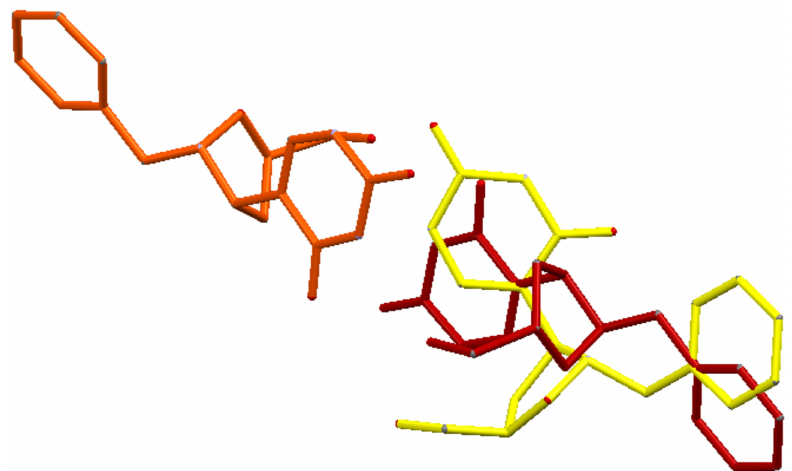
Figure 6. Structures overlay and comparison: X-ray inferred one (red and orange, Z’ = 2) and docked (yellow). (For interpretation of the references to color in this figure legend, the reader is referred to the web version of this